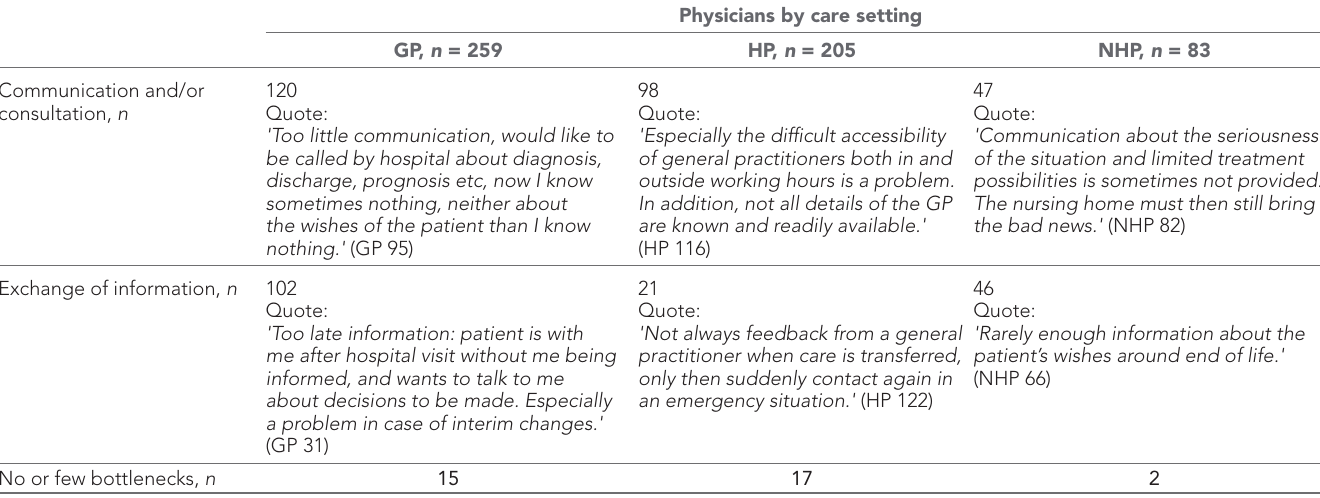
Physicians by care setting